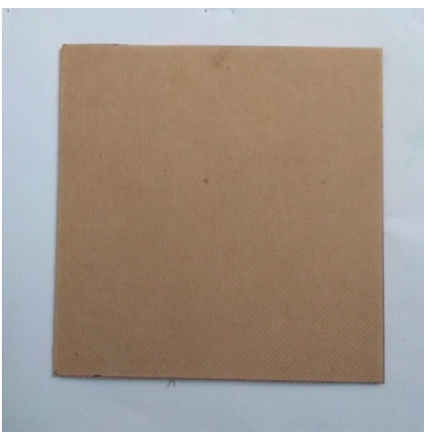
Figure 6: Press board used in the transformer.